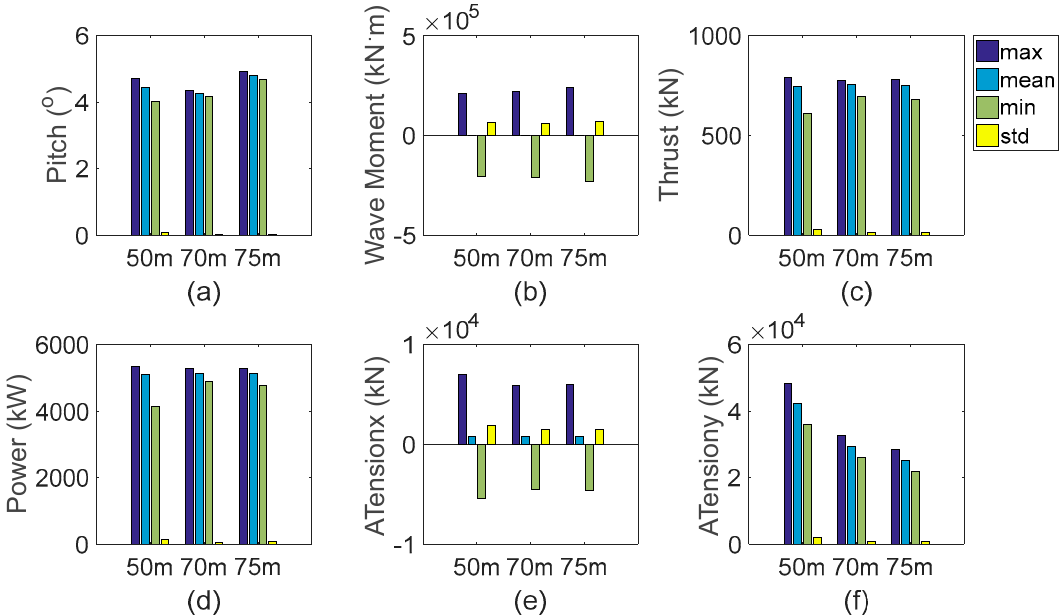
Figure 6. Statistic results of motion, aerodynamic performance, and hinged joint tensions. ( a ) Pitch angle ( b ) Wave moment in pitch ( c ) Thrust on the rotor ( d ) Output power ( e ) x-direction Tension on the articulated joint ( f ) y-direction Tension on the articulated